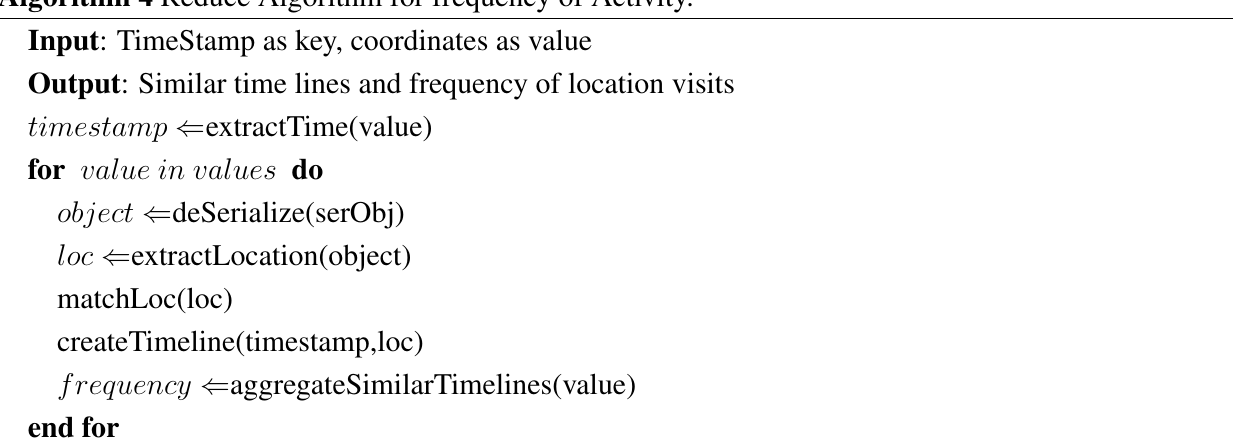
Algorithm 4 Reduce Algorithm for frequency of